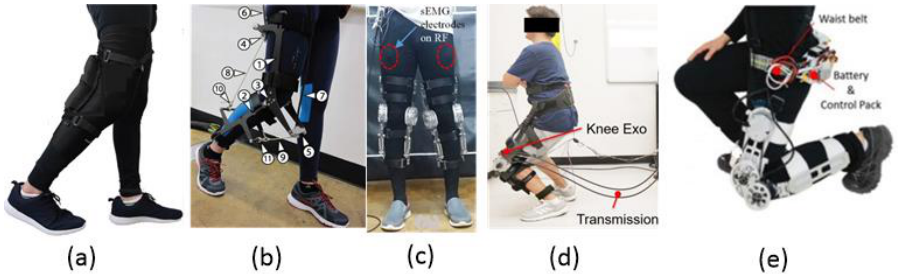
Figure 5. Knee exoskeletons using ( a ) an inflatable actuator [23], ( b ) a Bowden cable put in the front and back of the leg [24], ( c ) springs [10], ( d ) a DC motor and pulley [25], ( e ) double pulleys [26].